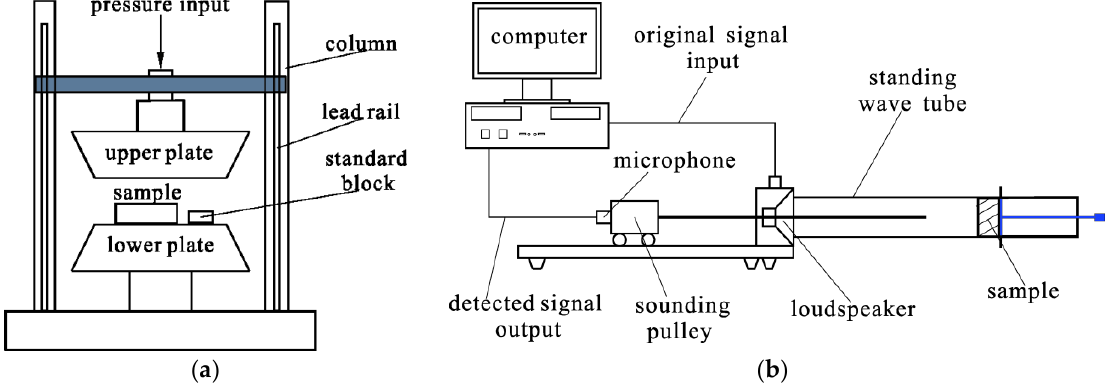
Figure 2. Schematic diagrams of the compression system and the measurement system. ( a ) CTM2050 for sample compression; ( b ) AWA6128A for sound absorption measurement.